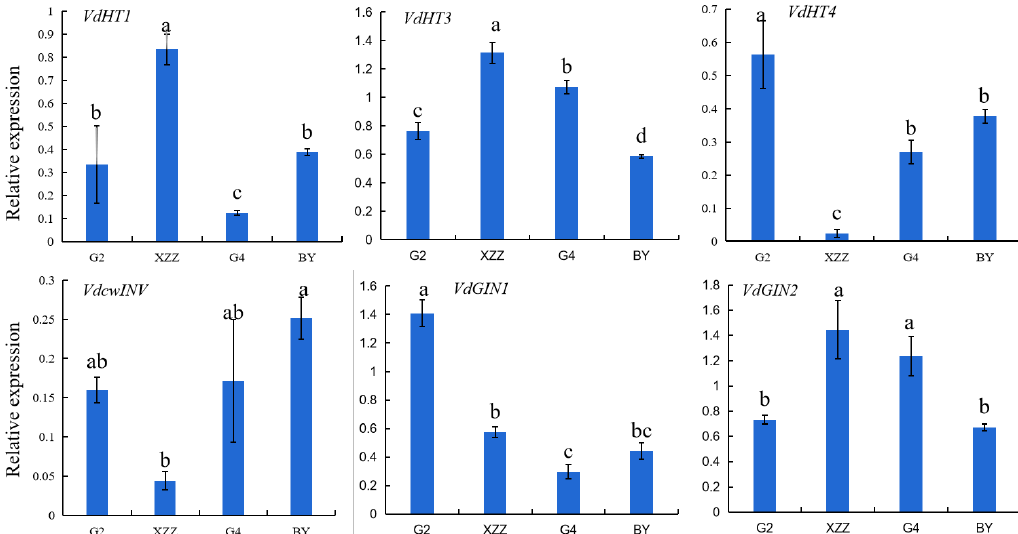
Figure 1. Expression levels of sugar unloading-associated genes in spine grapes. Values presented are means ± SD ( n = 3). VdGAPDH was used as reference gene. Different letters indicate significant differences among four spine grapes using Duncan’s test ( p < 0.05). G2: Gaoshan #2, G4: Gaoshan #4, XZZ: Xiangzhenzhu, BY: